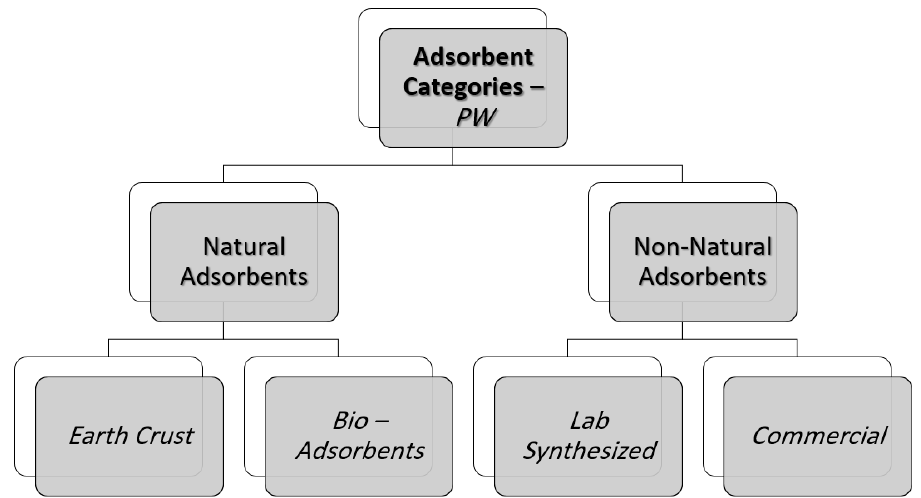
Figure 2. Classification of